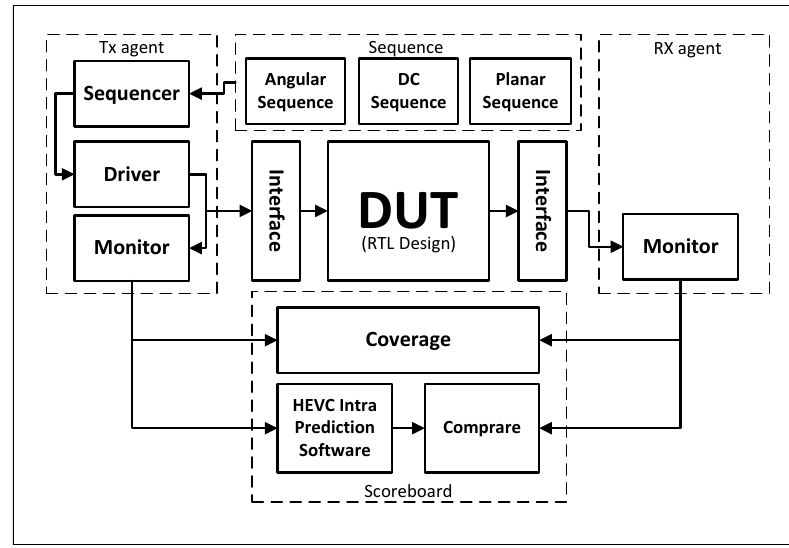
Figure 17. The structure of the verification environment used for our DUT.